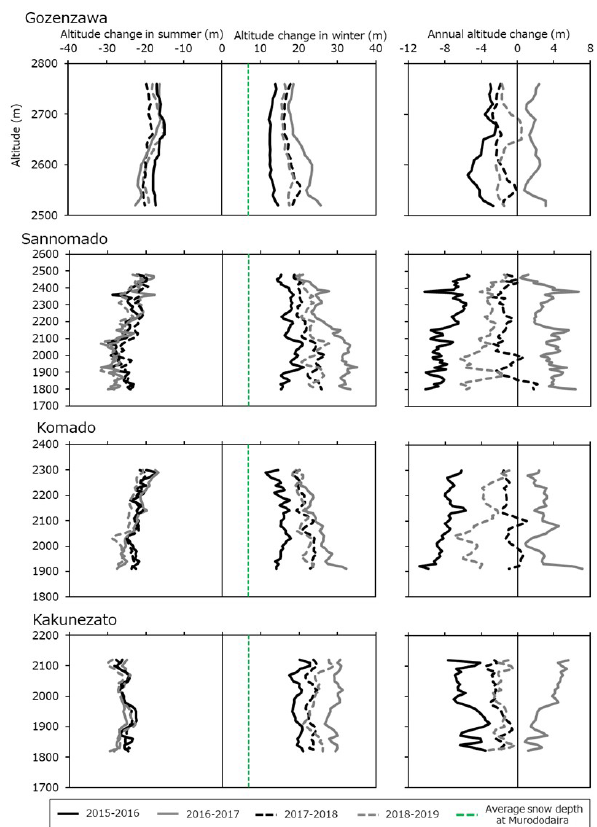
Figure 13. Profiles of the altitude changes of Gozenzawa, Sanno- mado, Komado, and Kakunezato glaciers. The green dashed line is at 6.8m, the average snow depth at Murododaira (Iida et al.,